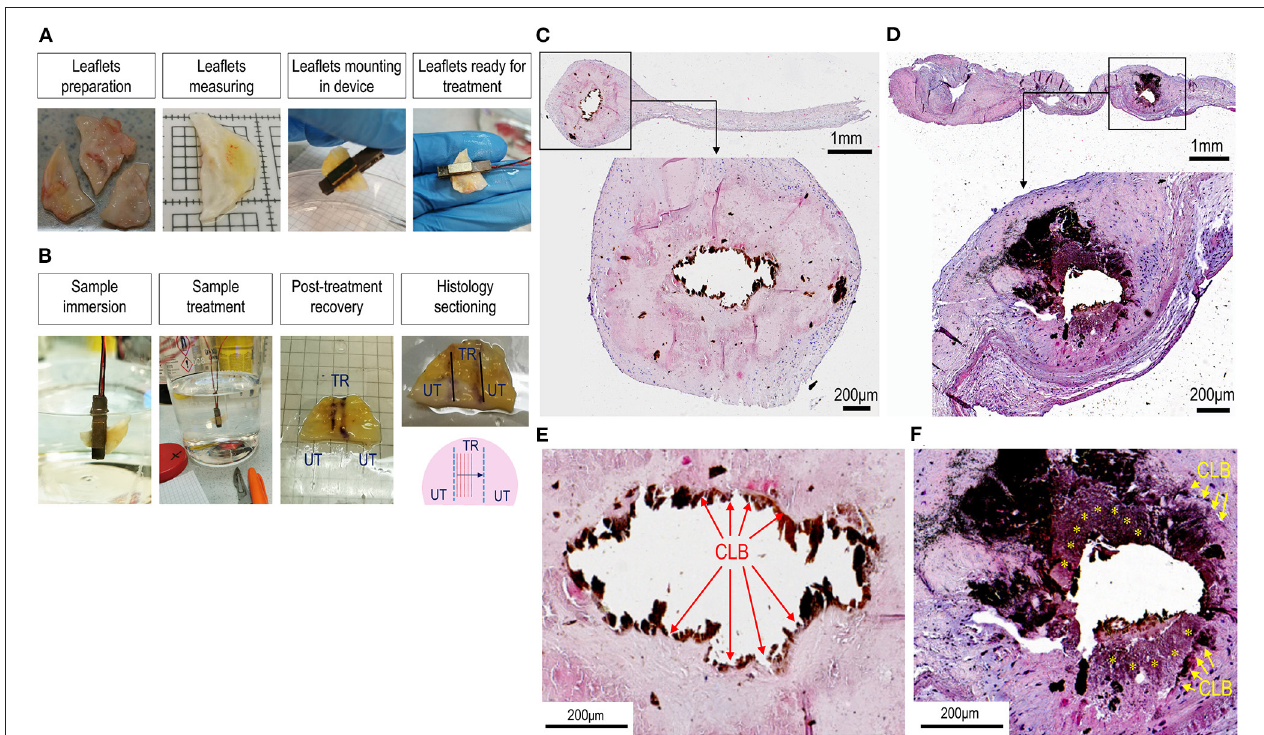
FIGURE 3 | Treatment of calcific aortic valve disease (CAVD) leaflets by TDD. (A,B) Show the sequence of the human CAVD leaflets mounting in the debridement device. After preparation, leaflets were individually placed among the two piezoelectric transducers and immersed into a phosphate-buffered saline (PBS) solution for the treatment. After treatment, the orientation of the treated zones (TR) was marked with a surgical pen to distinguish them from the untreated portions (UT). These marks were taken as a reference for histological sectioning that occurred in a transversal orientation as indicated in the lower right panel in (B) . (C,D) And the high magnifications of the histological regions represented therein (E,F) show the difference in the aspect of the calcifications in control (C,E) vs. the treated calcific leaflets (D,F) . It is remarkable that in control tissues there was a net boundary between the calcific lesions (removed by sectioning; CLB) and the surrounding sclerotic tissue (red arrows in E ). By contrast in treated tissues, the boundaries were less sharp (yellow arrows) and granular-like deposits (yellow asterisks) appeared around the lesions, suggesting a partial debridement of the calcium. See also Supplementary Figure S1 for another clear example of calcium debridement in a calcific human valve leaflet treated with TDD. Sections in C–F stained with von Kossa staining